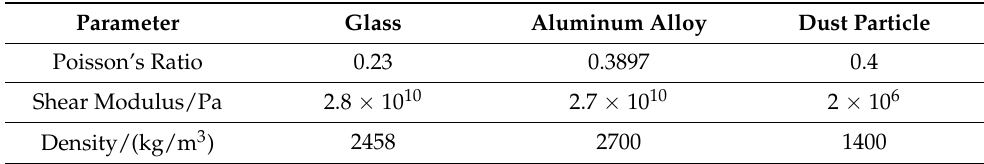
Table 2. Solar panel and dust physical